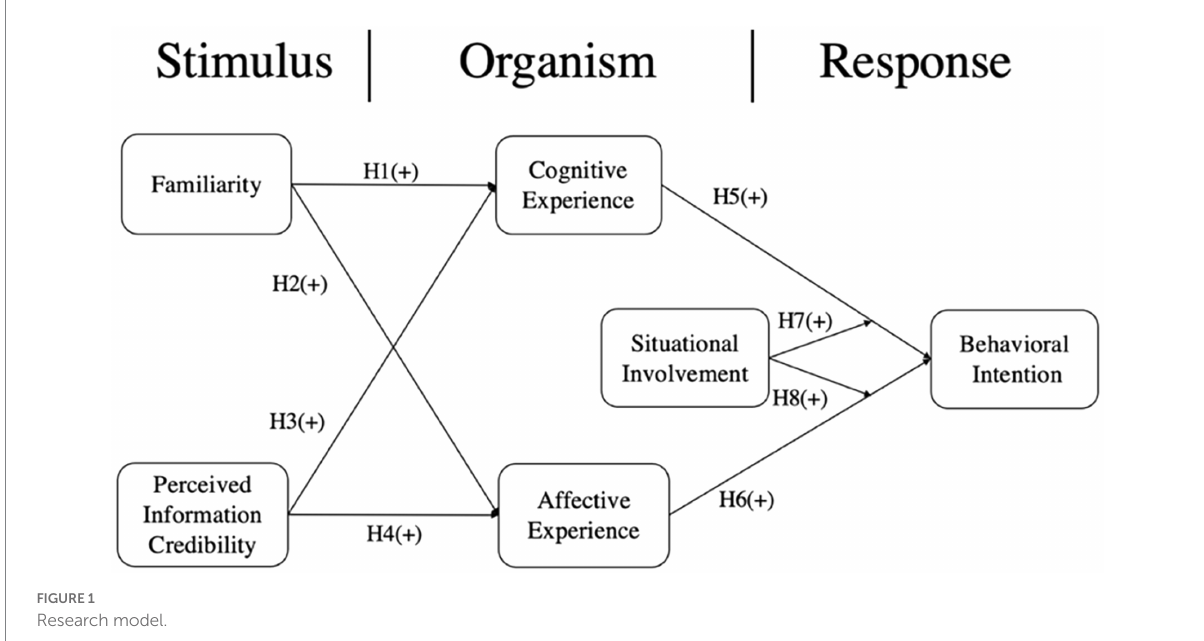
FIGURE 1 Research